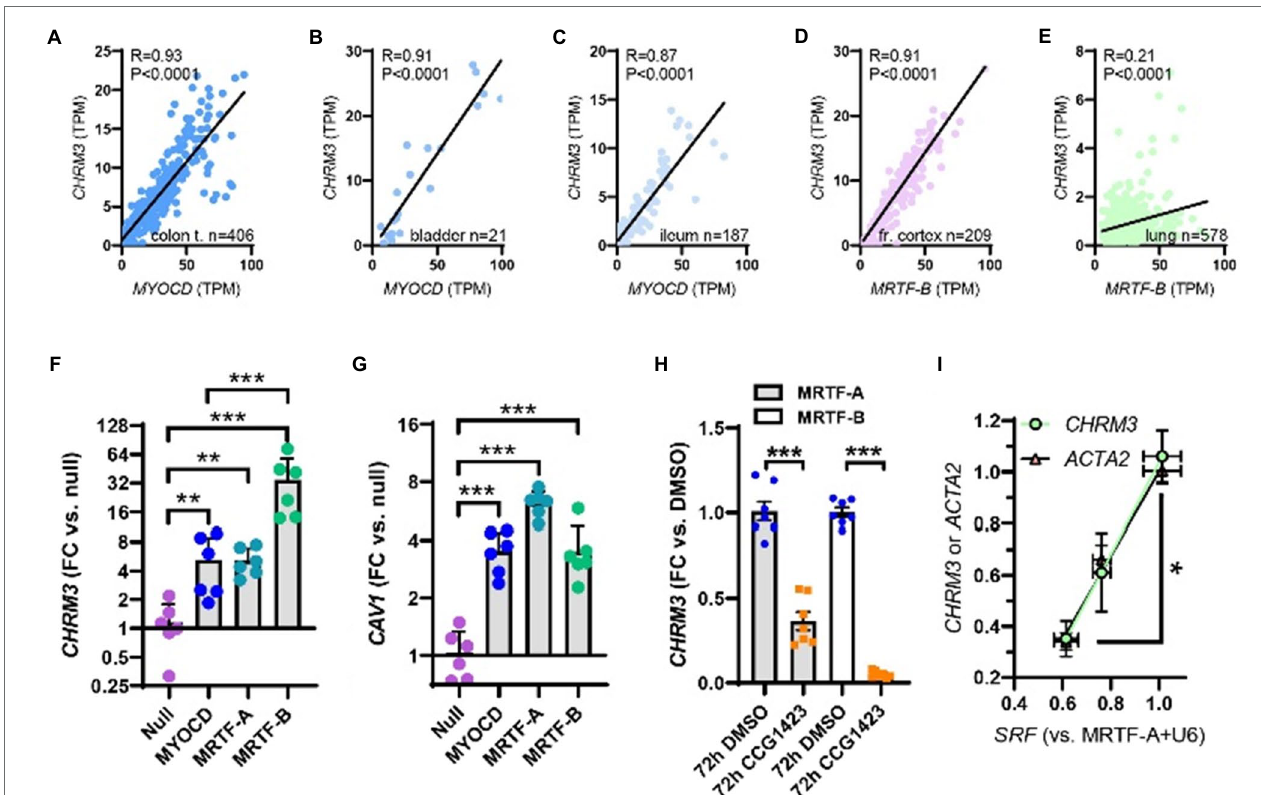
FIGURE 2 | Myocardin (MYOCD) correlates with the M 3 muscarinic receptor ( CHRM3 ) across human tissues and SRF is critical for CHRM3 regulation by MRTFs. (A) through (C) show correlations at the mRNA level of MYOCD vs. M 3 ( CHRM3 ) in the human gastrointestinal tract and urinary bladder. In brain (D) and lung (E) , MRTFB , rather than MYOCD , correlated with M 3 . This prompted us to examine if all MRTFs (MYOCD, MRTF-A, and MRTF-B) regulate M 3 at the mRNA level. Viral overexpression in human coronary artery SMCs showed that MRTF-B was a more effective transactivator of CHRM3 than MYOCD ( F , n = 6), despite having the same effect as MYOCD on another target ( CAV1 , G ). (H) Shows reduction of CHRM3 after treatment for 72 h with the MRTF-SRF inhibitor CCG-1423 (10 μ M, n = 6). Cells were transduced with either MRTF-A (gray bars) or MRTF-B (white bars). (I) Shows that knockdown of serum response factor (SRF, 0, 30, and 100 MOI of Ad-shSRF) reduces CHRM3 (green/black circles) in parallel with ACTA2 (pink/black triangles, n = 4, per condition). MRTF-A was overexpressed throughout in (I) . *** p <0.001, ** p <0.01, and * p <0.05